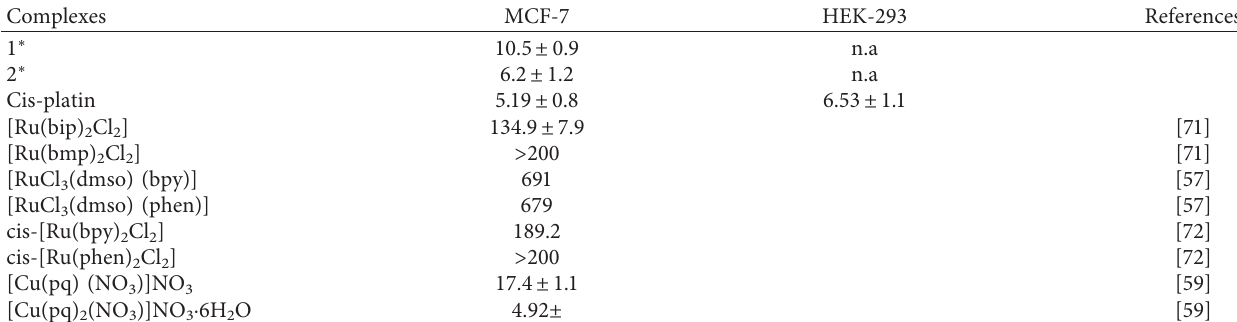
50 ( μ M) against MCF-7 cells).